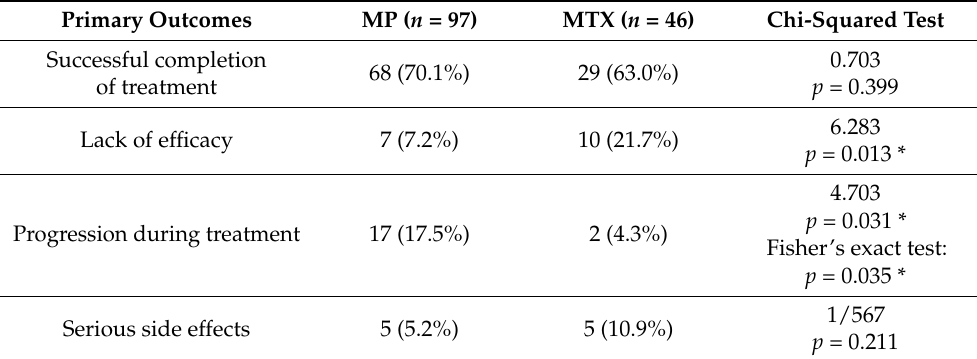
Table 2. Primary outcomes in patients with pulmonary sarcoidosis after MP and MTX